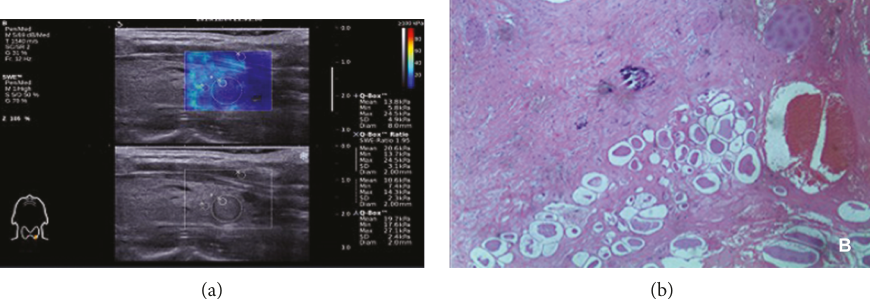
Figure 1: Thyroid follicular adenoma in a 52-year-old woman. (a) Conventional US image represents isoechoic, well-de fi ned margins and without microcalci fi cation. 2D-SWE mapping shows a homogeneous blue pattern indicative of a low Young ’ s modulus. (b) Histological imaging was performed for veri fi cation after surgery; HE, 40x magni fi cation.